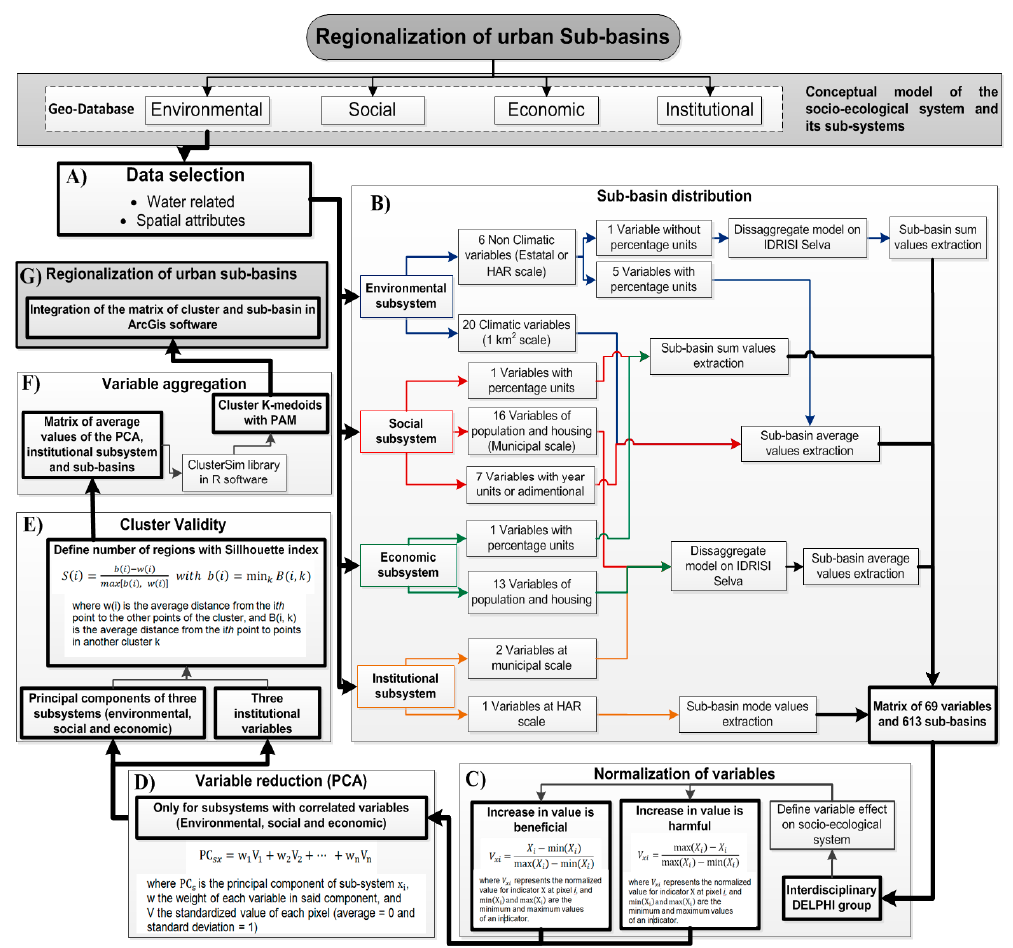
Figure 2. Regionalization methodology for delimiting urban sub-basins based on socio-ecological variables (See Appendix B for description of variables). HAR: Hydrological Administrative Region, PCA: Principal Component Analysis, PAM: Partitioning Around Medoids.